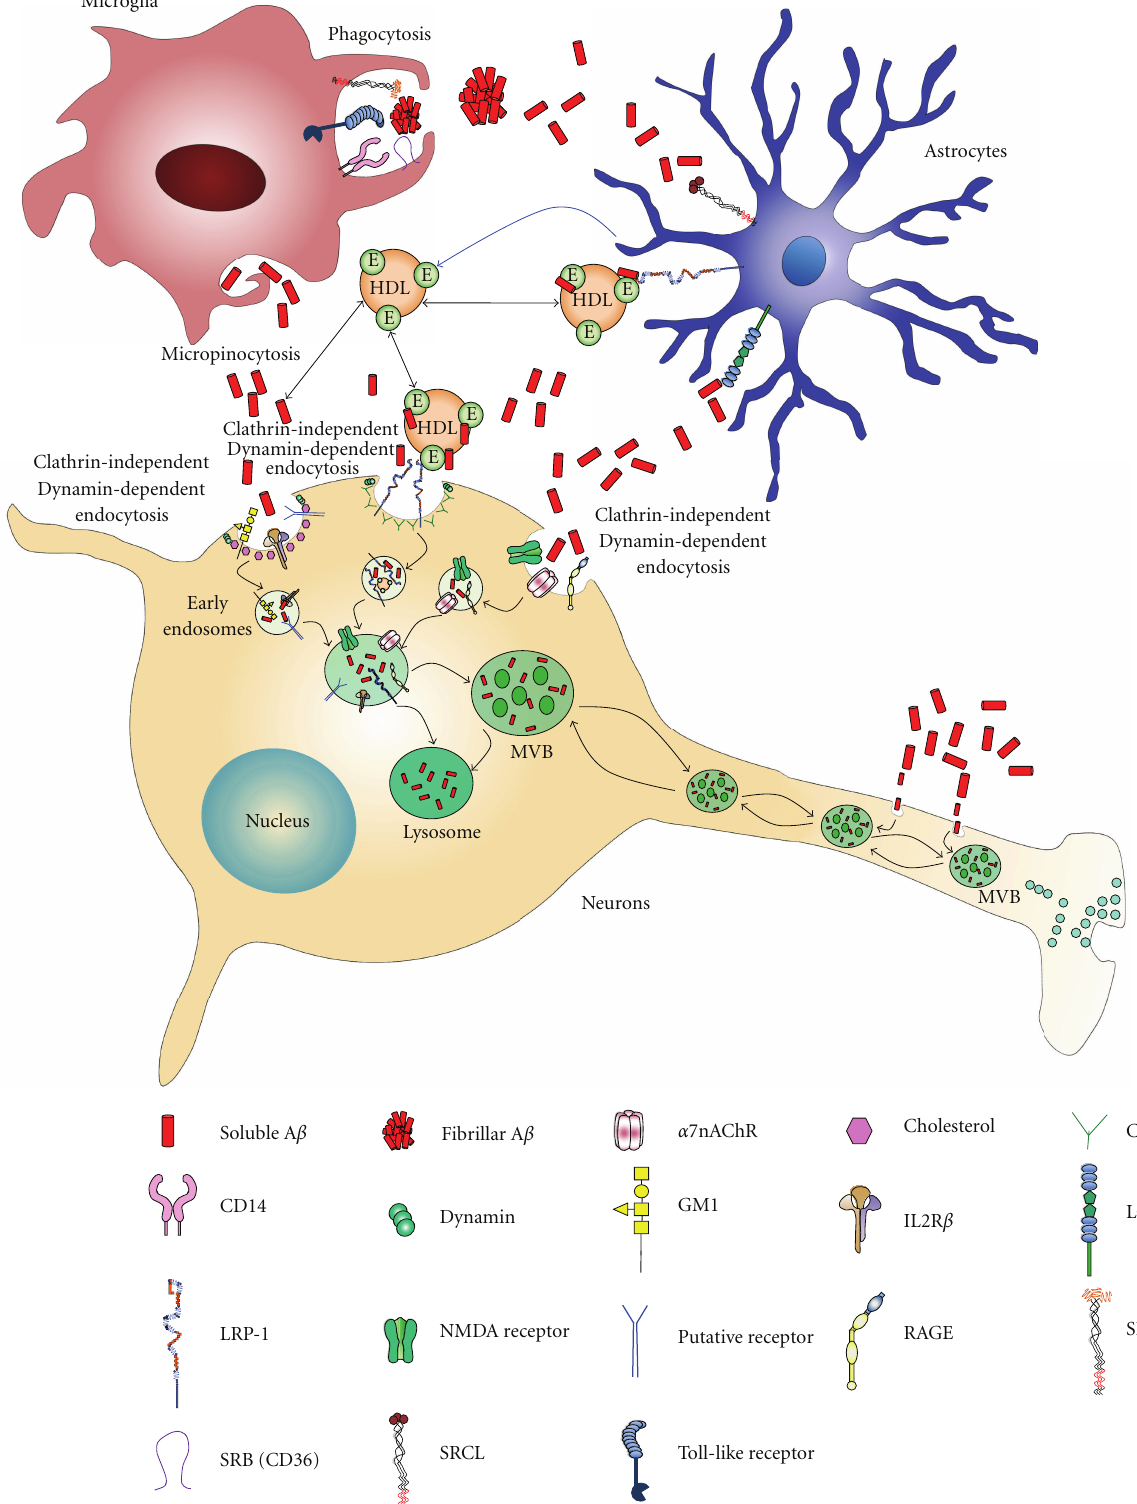
Figure 1: Mechanisms of A β internalization in neurons and